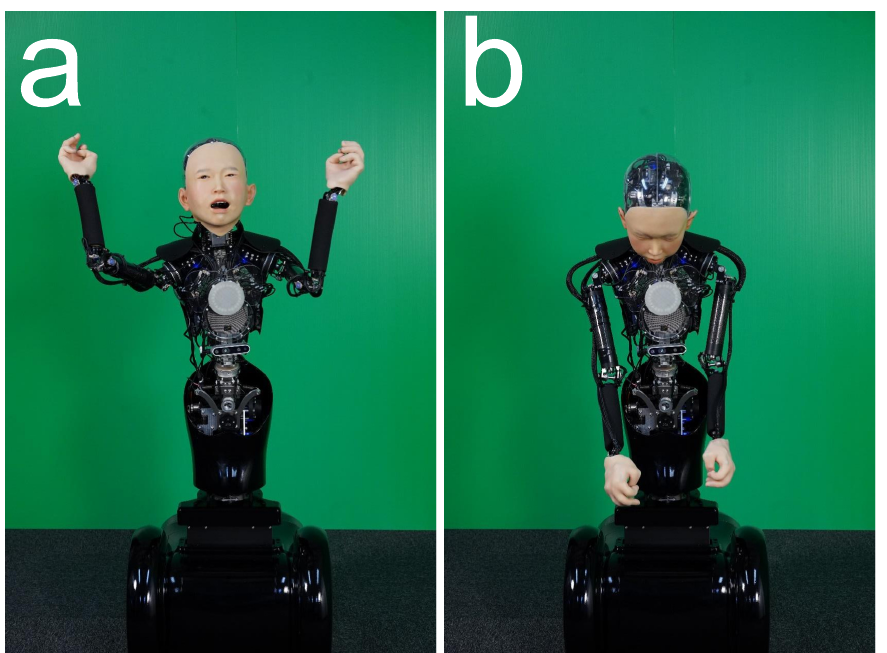
Fig 8. Two representative postures which have distinguishable facial expressions by adding body expressions. (a) The posture -17/A at the highest facial valence / (b) The posture 43/C at the lowest facial valence.